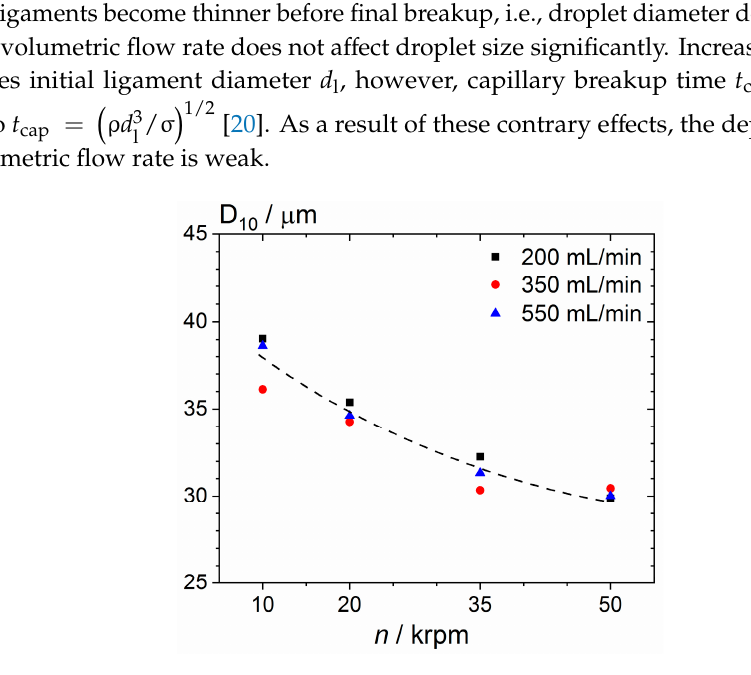
Figure 8. Arithmetic mean droplet diameter D 10 of the waterborne basecoat as a function of rotational speed n for different volumetric flow rates (cid:1848)(cid:4662) .